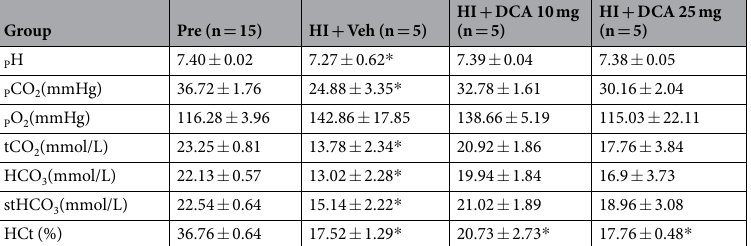
Table 1. Blood gas and hematocrit changes with HI and DCA treatment. Arterial blood was sampled before hemorrhage (Pre) and at 3 hours post resuscitation. * p < 0.05. All the parameters were measured using a blood gas analyzer using 120 ul of blood. Abbreviations: pCO 2 = partial pressure of CO 2 ; pO 2 = partial pressure of oxygen;